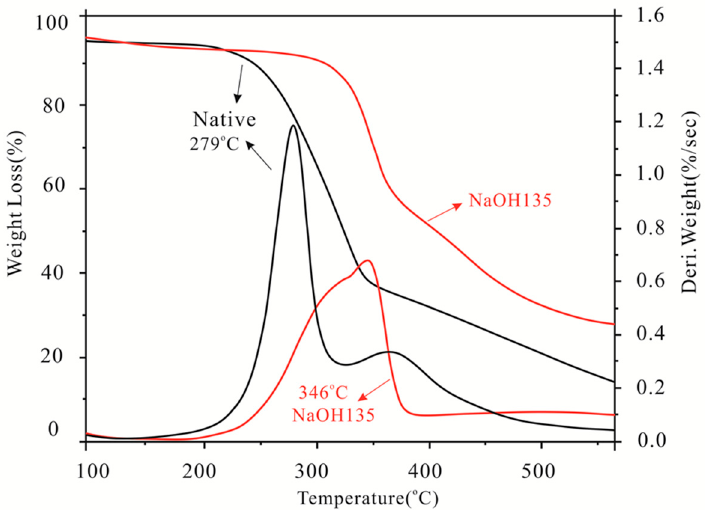
Figure 6. Thermogravimetry of the pretreated bamboo and native bamboo samples. Table 4. Pyrolysis characteristics of the native material and pretreatment bamboo samples.